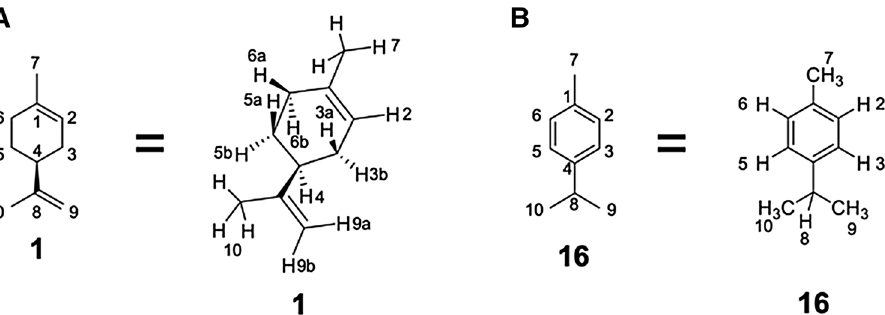
Figure 2. Chemical structures of substrates, such as ( A ) ( S )-(−)-limonene ( 1 ) and (B) p -cymene ( 16 ), with a number to each carbon and hydrogen atom. All 16 and 14 hydrogen atoms in (S)-(-)-limonene and p-cymene ( 16 ), respectively, were used to define the docking pose